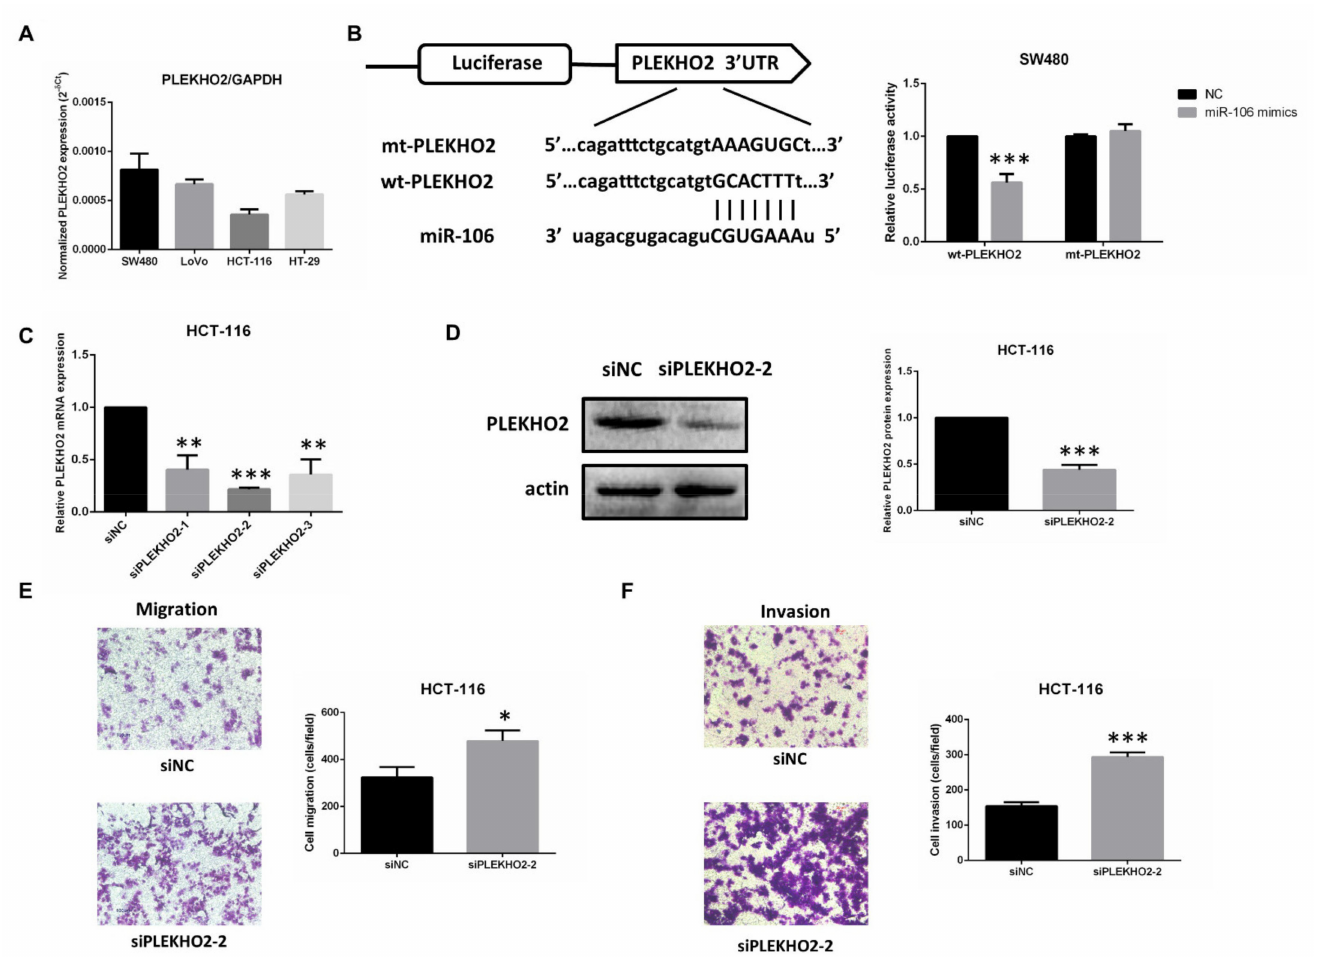
Figure 5. PLEKHO2 is a direct target gene of miR-106b. ( A ) The mRNA level of PLEKHO2 in 4 CRC cell lines was analyzed by qPCR. GAPDH served as an internal control. ( B ) Schematic illustration shows wild type and mutated 3 (cid:48) -UTR of PLEKHO2. A luciferase activity assay was used to identify the miR-106b binding site. ( C , D ) Transfection efficiency of PLEKHO2 siRNA in HCT-116 cells was analyzed by qPCR and Western blot assay. ( E , F ) Transwell assay showed that the inhibition of PLEKHO2 in HCT-116 cells promotes both migration and invasion compared with the negative control. All data are shown as the mean ± SD ( n = 3), * p < 0.05, ** p < 0.01, *** p <